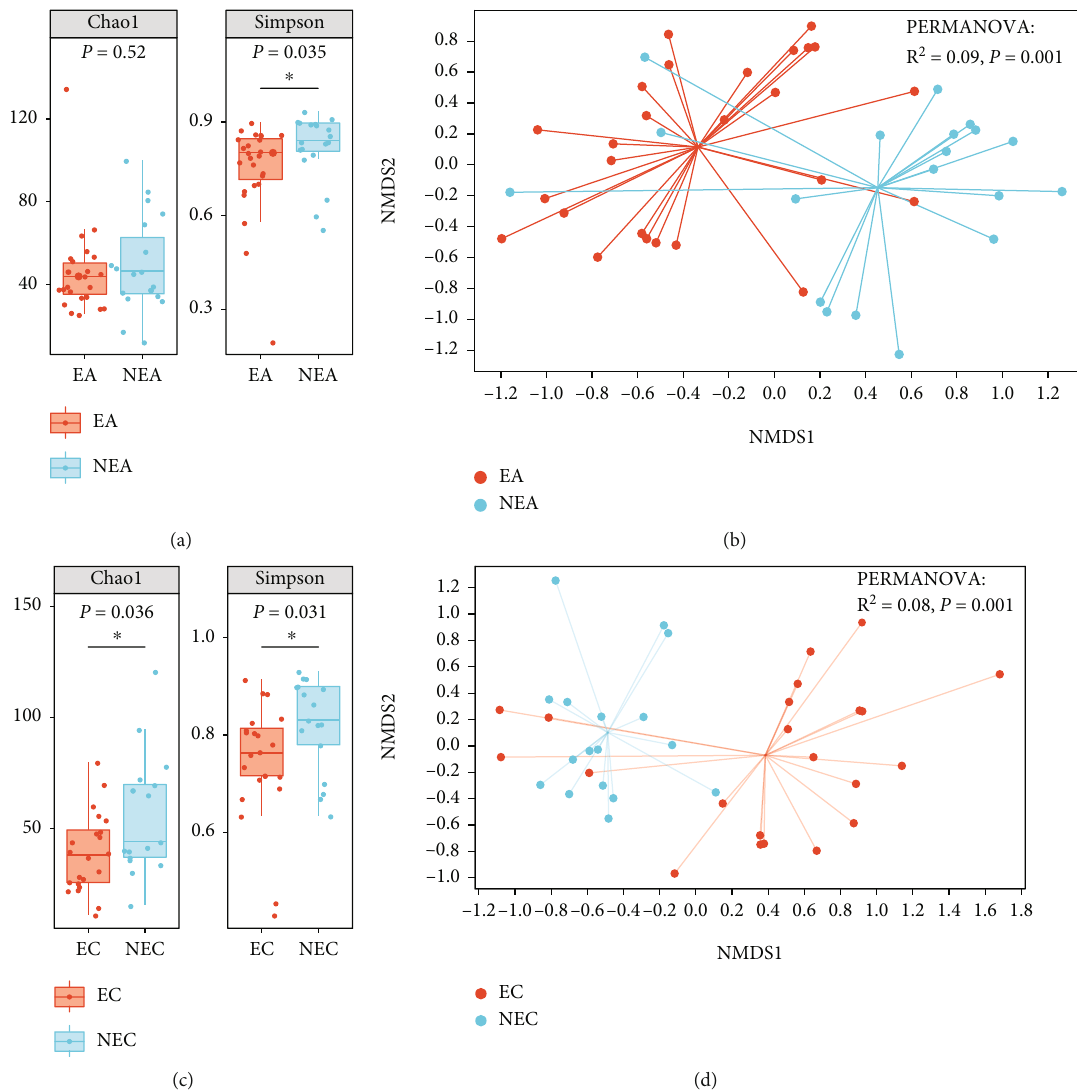
Figure 2: Alpha diversity and beta diversity of fungal microbiota. Each dot reprented a sample. Box plots of the Chao1 index and Simpson index, to compare alpha diversity (a) between EA and NEA and (c) between EC and NEC. The y -axis represented the value of the corresponding Chao1 or Simpson index. The statistical analysis was performed using Wilcoxon rank-sum test and Dunn ’ post hoc test. NMDS analysis based on the Bray-Curtis distance to compare beta diversity (b) between EA and NEA and (d) between EC and NEC. PERMANOVA was employed to reveal beta diversity